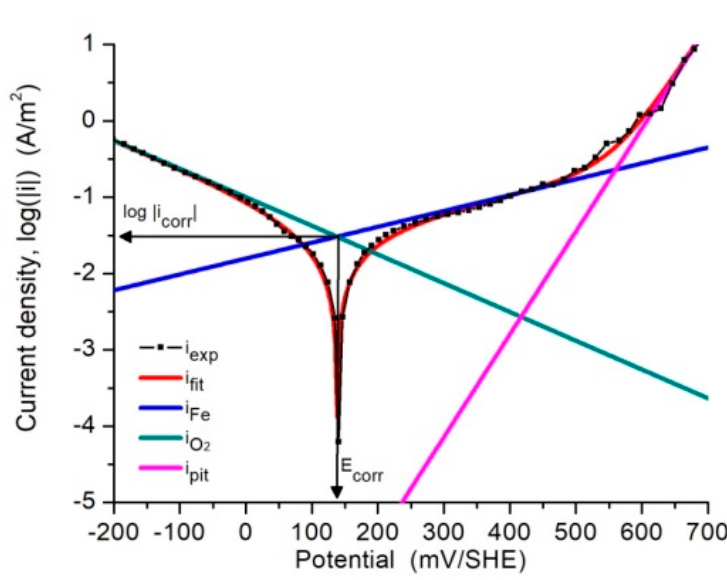
Figure 7. Synthesis of polarization curves for AISI 304L stainless steel immersed in filtered solution at 8000 rpm.